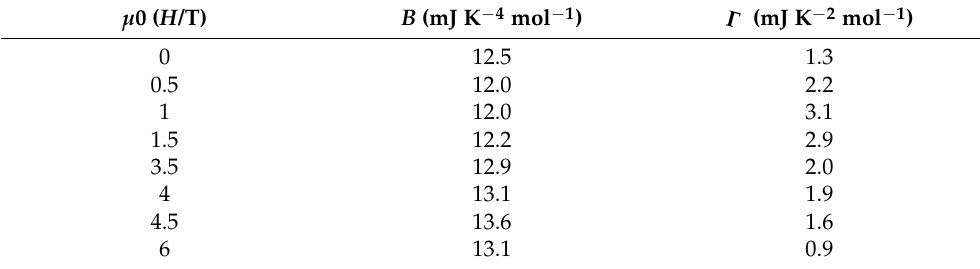
Table 1. The thermodynamic parameters of the electronic heat capacity coefficient, γ , and the Debye term, β , for each magnetic field between 0 T and 6